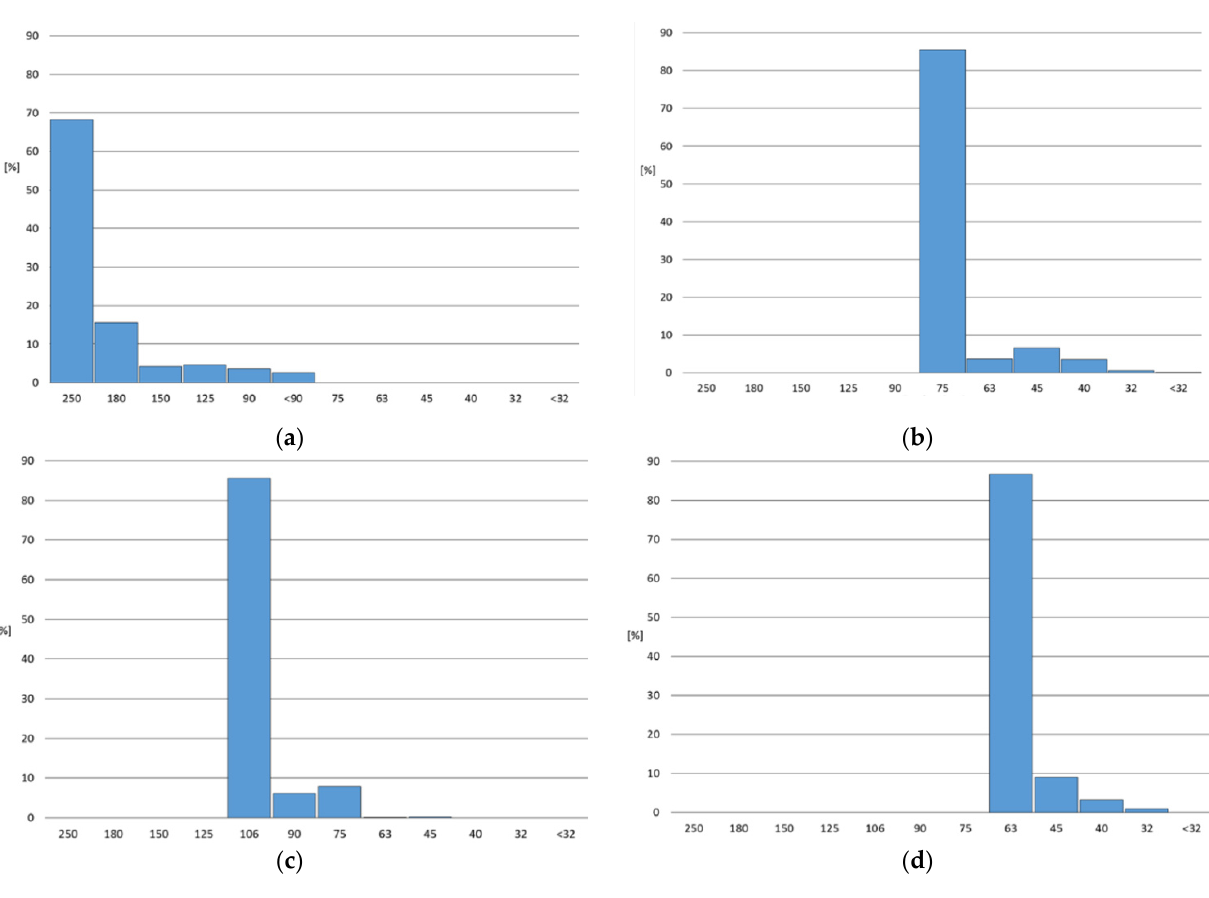
Table 6. Presentation of material parameters of spruce dust samples.